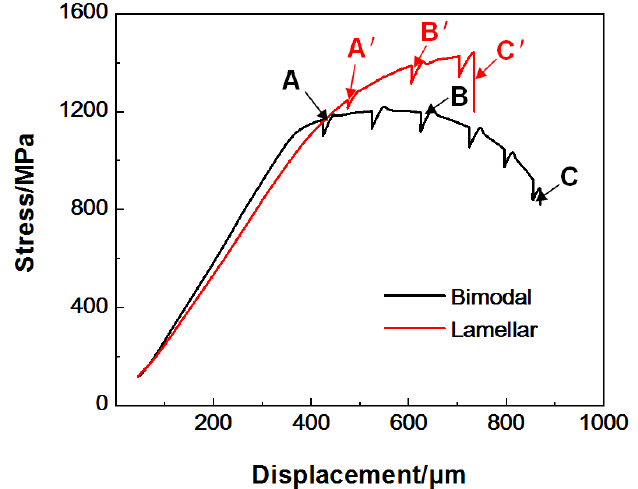
Figure 4. The stress–displacement curves of samples with bimodal and lamellar microstructures stretched in situ at room temperature.